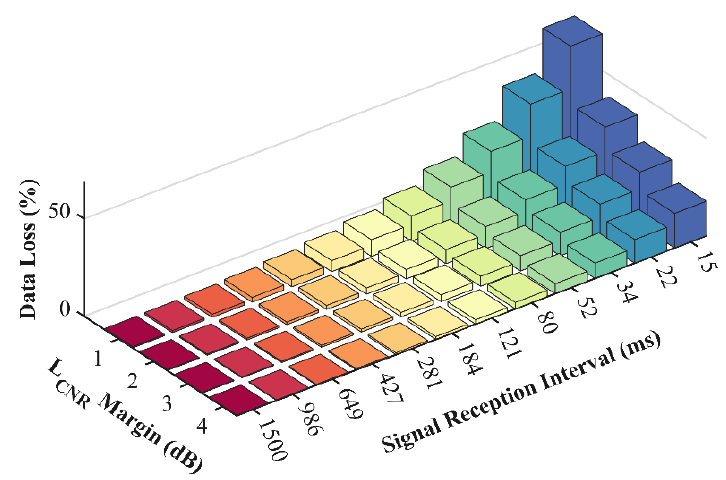
Figure 7. The effect of signal reception interval on data loss.